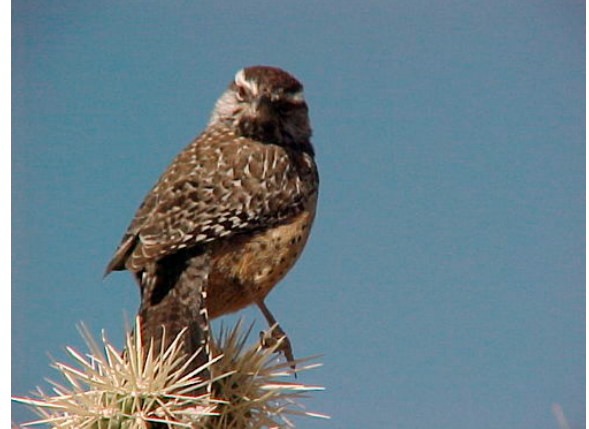
Figure 7. Example image from Caltech-UCSD Birds.